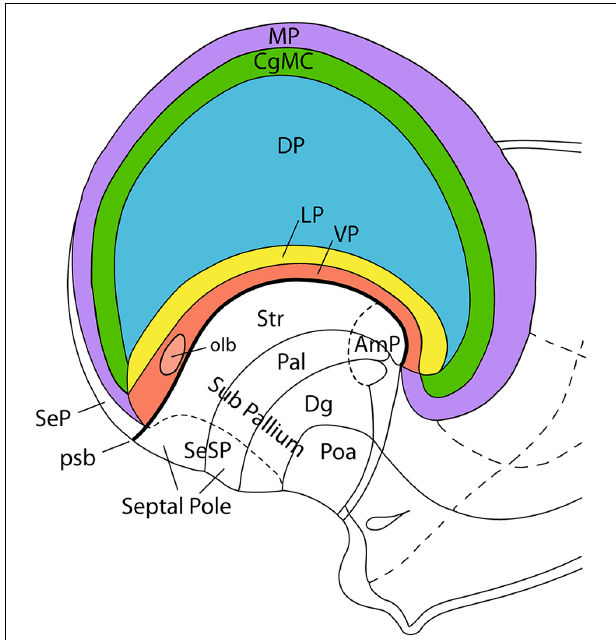
FIGURE 3 | Incipient axial bending in the mammalian telencephalon, divided into pallial regions. This schema represents the pallial bauplan showing medial (MP; violet), dorsal (DP; blue), lateral (LP; yellow), and ventral (VP; red) pallial regions. The cingulate mesocortex (CgMC; green) is included as well, so that MP and VP form the external allopallial ring, while CgMC and LP form the transitional mesopallial ring that encloses the central DP island. The schema shows how the flat pallial map shown in Figure 1 can be visualized in a lateral view at an embryonic stage in which the septal and amygdalar poles of the hemisphere (Septal Pole; AmP) start to be pushed downwards by differential growth of the DP (isocortex). This incipient deformation carries with it the other components of the pallial map, which result similarly stretched into a curved inverted C-shaped arrangement. Each pallial region nevertheless maintains its fundamental dorso-ventral and rostro-caudal topology throughout the ensuing morphogenetic process. Abbreviations: pallial/subpallial boundary (psb), pallidum (Pal), striatum (Str), diagonal domain (Dg), preoptic area (Poa), pallial septum (SeP), subpallial septum (SeSP), olfactory bulb (olb). This figure was adapted from an illustration in Nieuwenhuys et al.